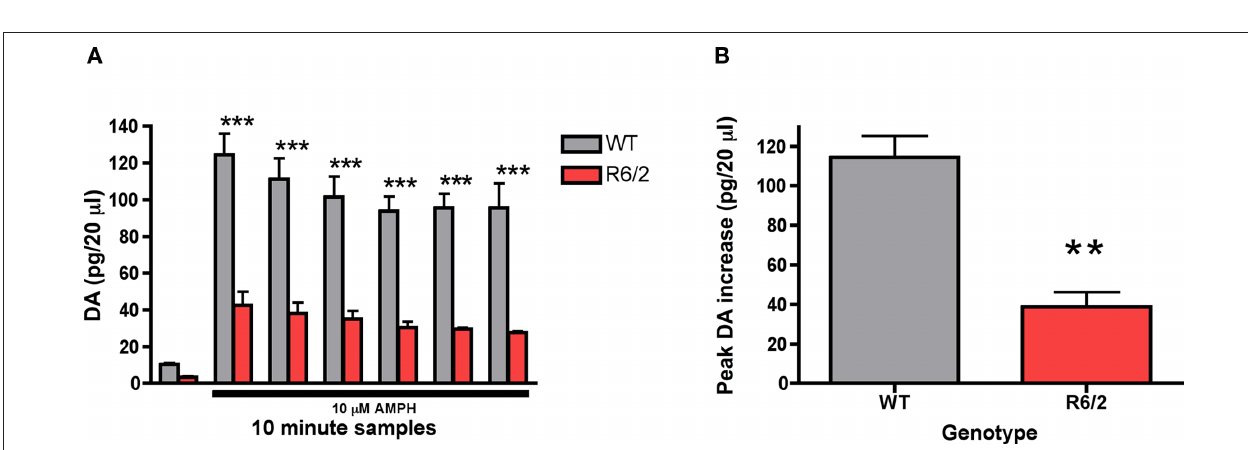
Figure 5 | In vivo microdialysis measurements of basal levels of extracellular (A) dopamine and (B) DOPAC in striatum of 7-month-old YAC128 mice ( n = 7 WT, 9 YAC128). Data are picograms per 20 μl sample. All data are mean ± SEM. * Indicates significantly different from WT, p < 0.05.